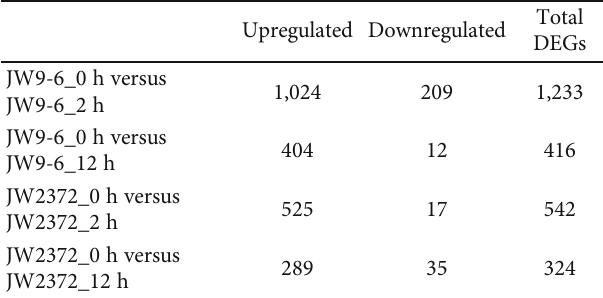
Figure 1: Venn diagram analysis of identi fi ed DEGs under salinity stress in shrub willow. (a) Principal component analysis of all samples. (b) Venn diagrams showing unique and shared DEGs between time points under salinity stress. Table 1: Number of DEGs at di ff erent salinity stress time points in the two